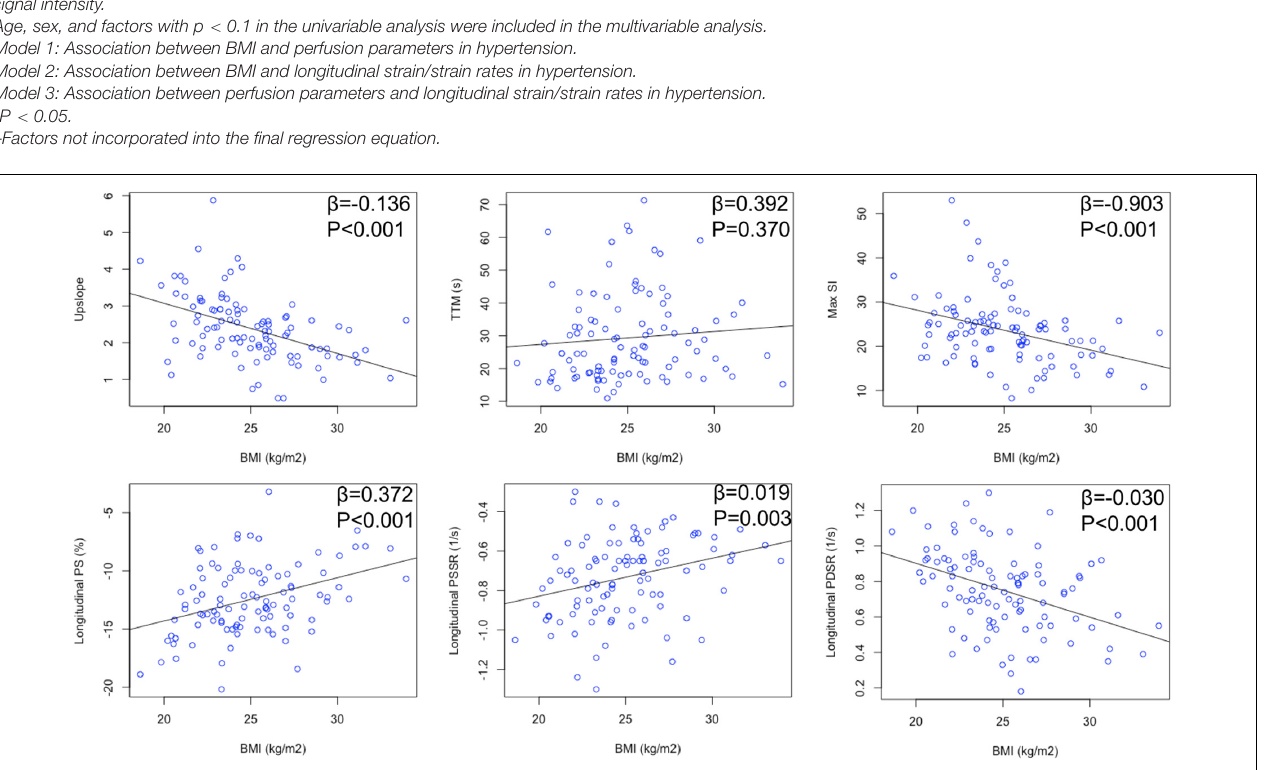
FIGURE 3 | Relationship between BMI and myocardial perfusion/LV deformation in hypertensive